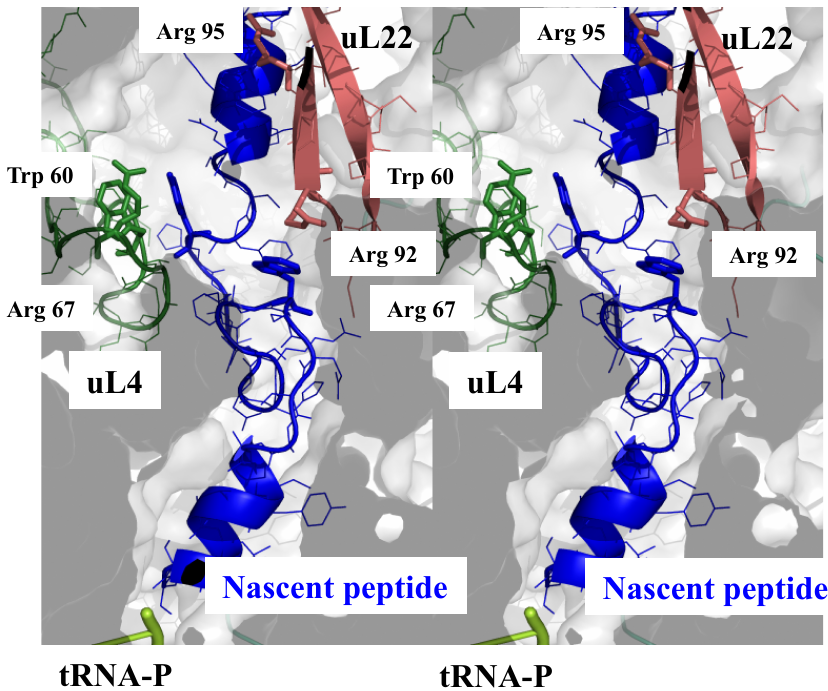
Figure 4. Sensing the interior of the tunnel. Side stereoview of the peptide tunnel showing the interactions between the r-protein uL4 (green) and uL22 (brown) with the stalled nascent peptide VemP (blue). rRNA is represented by a white transparent surface (pdb_id: 5nwy).